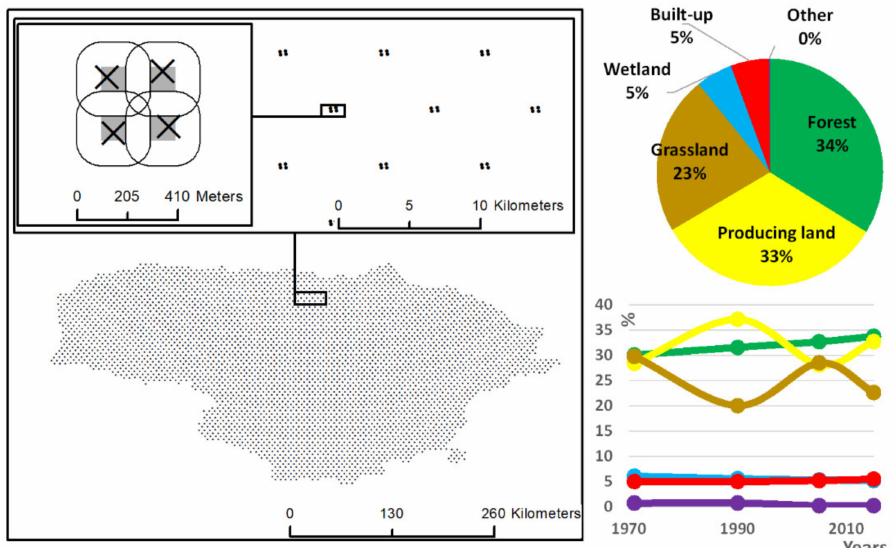
Figure 2. Specification of the study area: ( left ) associative illustration of the distribution of sample plots at different scales, with gray squares referring to the 100 × 100 m cells associated with Lithuanian National Forest Inventory (NFI) sample plots with 100 buffers used to extract driver variables for land use change modeling; ( right ) proportions of major land use types in Lithuania in 2015 and changes in proportions since 1971. Source of the data used: Lithuanian National Forest